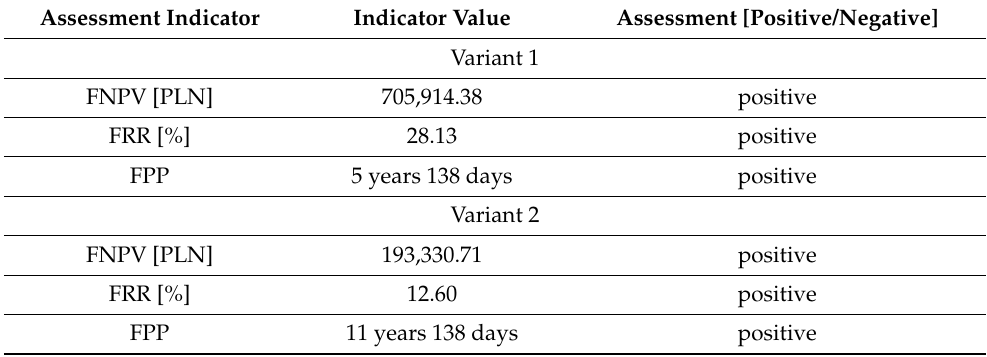
Table 22. Results of the evaluation of the financial effects of the project implementation. Source: designed by